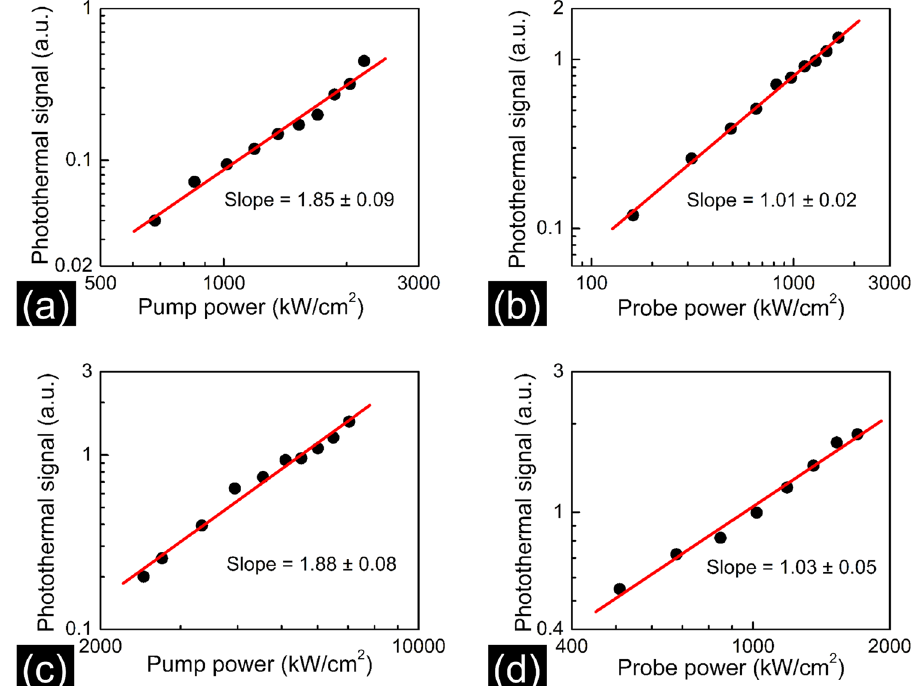
Figure 3. ( a ) pump and ( b ) probe power dependence of two-photon photothermal signal measured for 70 nm BaTiO 3 nanoparticle. The probe power employed in ( a ) is 0.8 mW and the pump power employed in ( b ) is 6 mW. ( c , d ) shows the pump and probe power dependence of two-photon photothermal signal measured for 20 nm BaTiO 3 nanoparticle respectively. The probe power employed in ( c ) is 0.8 mW and the pump power employed in ( d ) is 8 mW The signal varies quadratically with the pump power and linearly with the probe